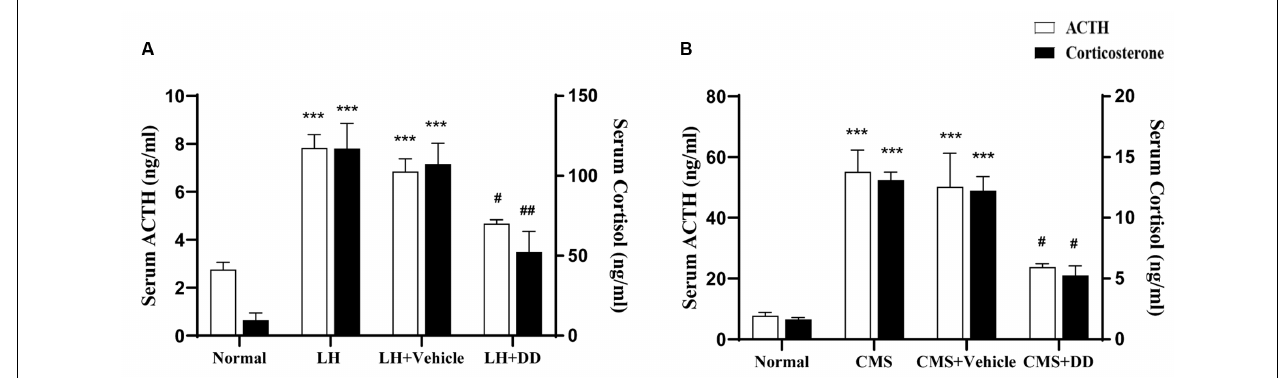
FIGURE 4 | Sub-chronic and Chronic administration of daidzein restored stress-induced disturbances in the hypothalamic pituitary adrenal (HPA) axis. (A) Sub-chronic administration of daidzein showed that there was significant increase in ACTH levels after rats were submitted to inescapable shock as compared to the normal group. Sub-chronic daidzein decreased serum ACTH levels compared to the LH group. Application of inescapable shock also increased corticosterone as compared to the normal group. Daidzein decreased serum corticosterone level significantly compared with the LH group. No difference was found in serum corticosterone levels between the LH group and vehicle group ( p > 0.05). (B) Serum levels of ACTH and corticosterone were significantly higher in CMS mice compared to normal group. Daidzein administration for 3 weeks, significantly attenuated the increase of serum ACTH and corticosterone in CMS mice. *** p < 0.001, # p < 0.05, ## p <